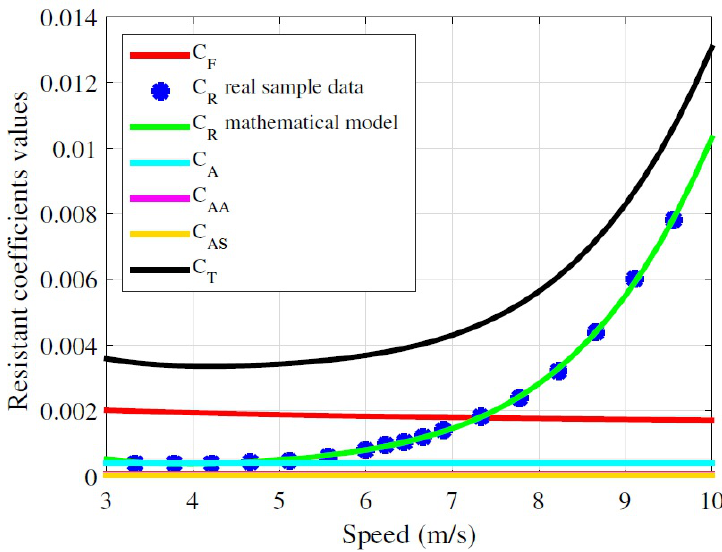
Figure 3. The resistance coefficients versus shipping